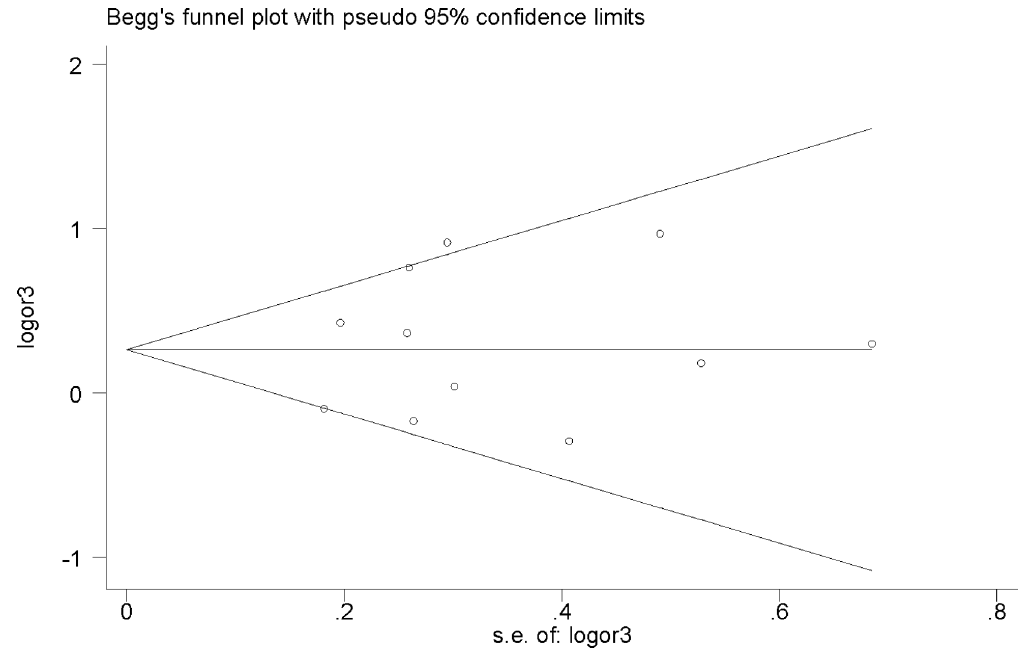
Figure 5. Begg’s funnel plot for publication bias test. IL1-RN VNTR: 2 versus L.